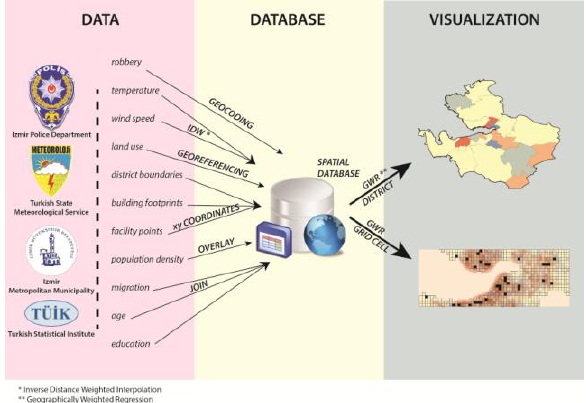
Figure 1. Organization, storage and visualization of data with using adopted